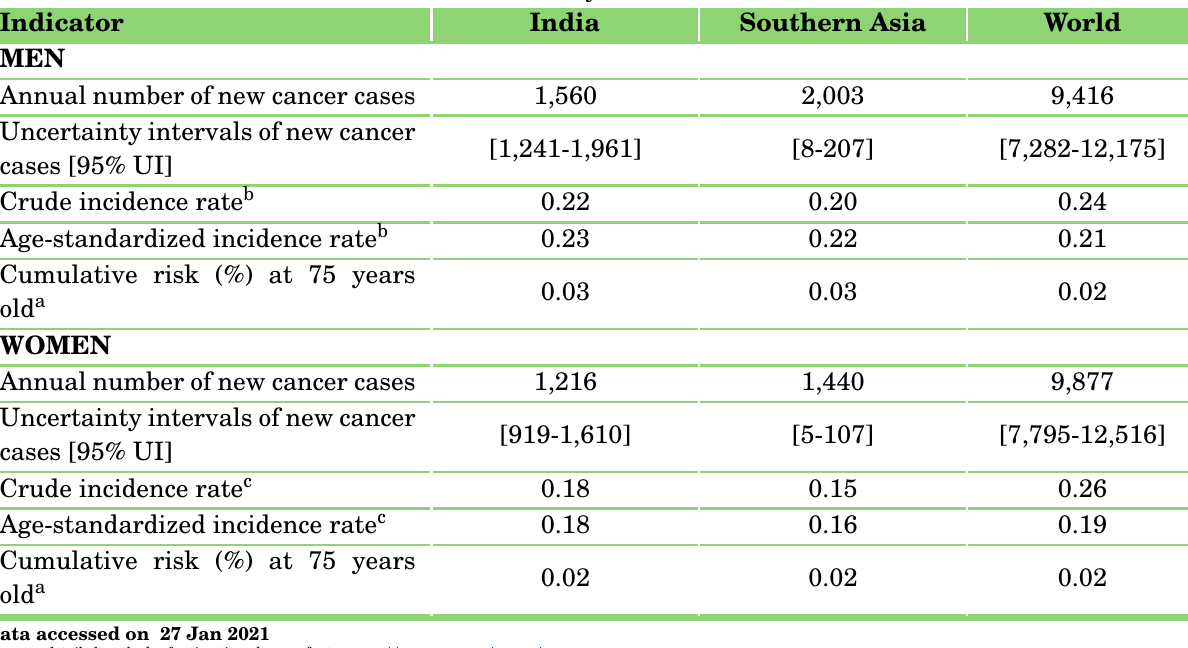
Table 8: Anal cancer mortality in India (estimates for 2020)